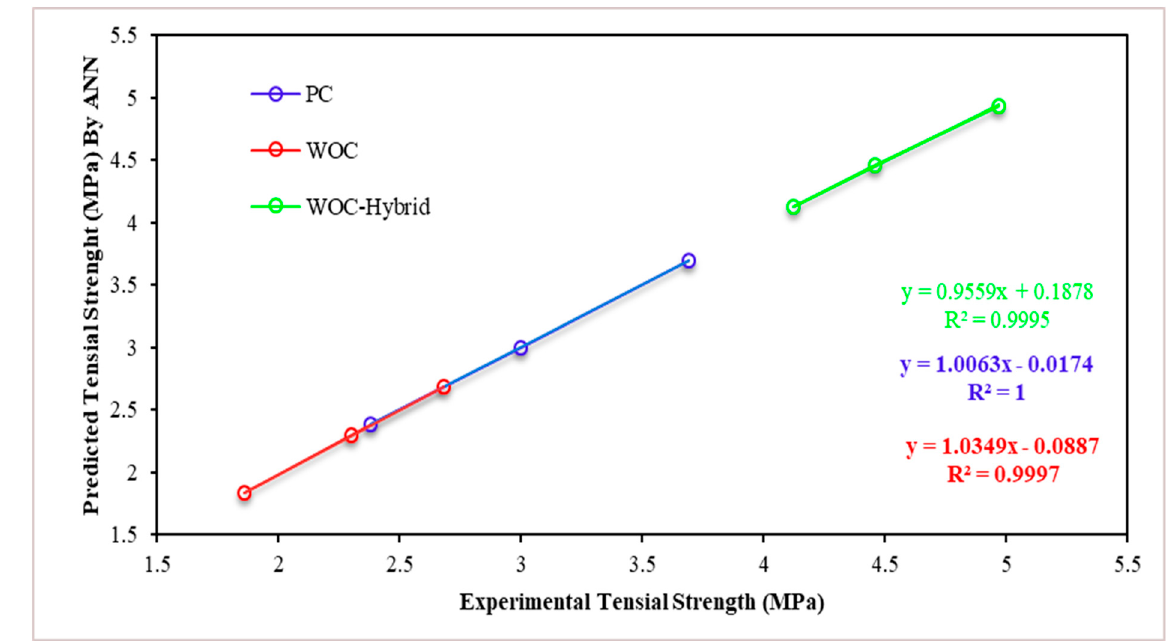
Figure 20. Linear relationship between measured and predicted Tensile strengths (the Levenberg– Marquardt back-propagation algorithm).